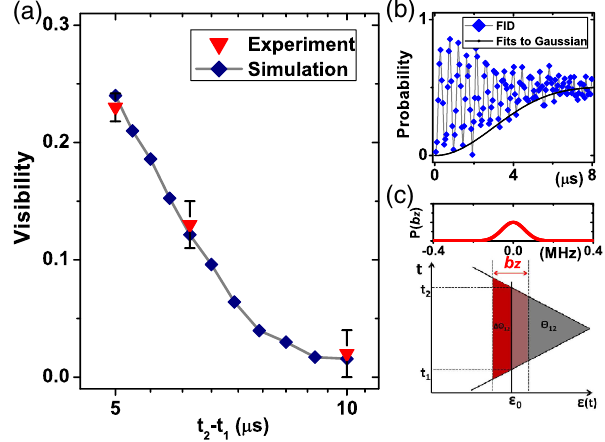
FIG. 4. Decoherence in the LZS process. (a) Measured (red triangles) and simulated (blue rectangles) visibility as a function of duration between the two LZ tunneling events. Agreement between theory and experiment confirms that the decay of the LZS visibility is dominated by the same source that results in the FID decay, which is generally the thermal fluctuations of the nuclear spin bath. (b) Measured FID signal; data are fitted to Gaussian decay (black line). (c) An intuitive picture can be employed to understand these observations. The fluctuations of . It changes nuclear spins produce an effective magnetic field b z (cid:4) 12 , which is proportional to the area of the gray regime, with the result that the phase information is washed